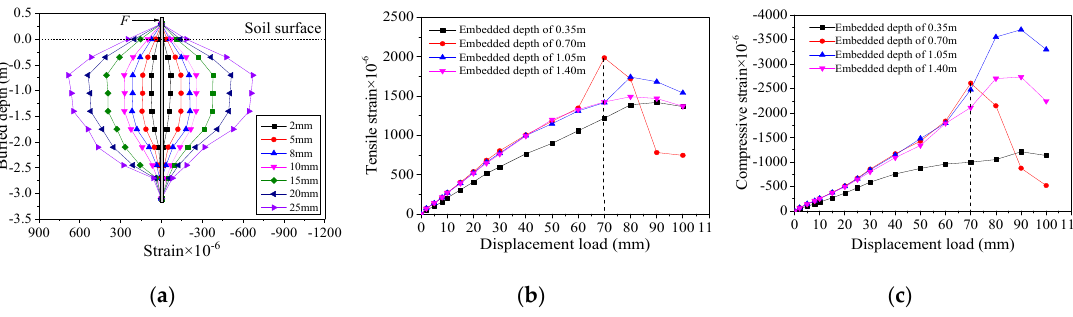
Figure 13. Strain distribution of HP-5 specimen. ( a ) Compressive and tensile strain distributions. ( b ) Tensile strain versus loading history. ( c ) Compressive strain versus loading history. Appl. Sci. 2020 , 10 , x FOR PEER REVIEW